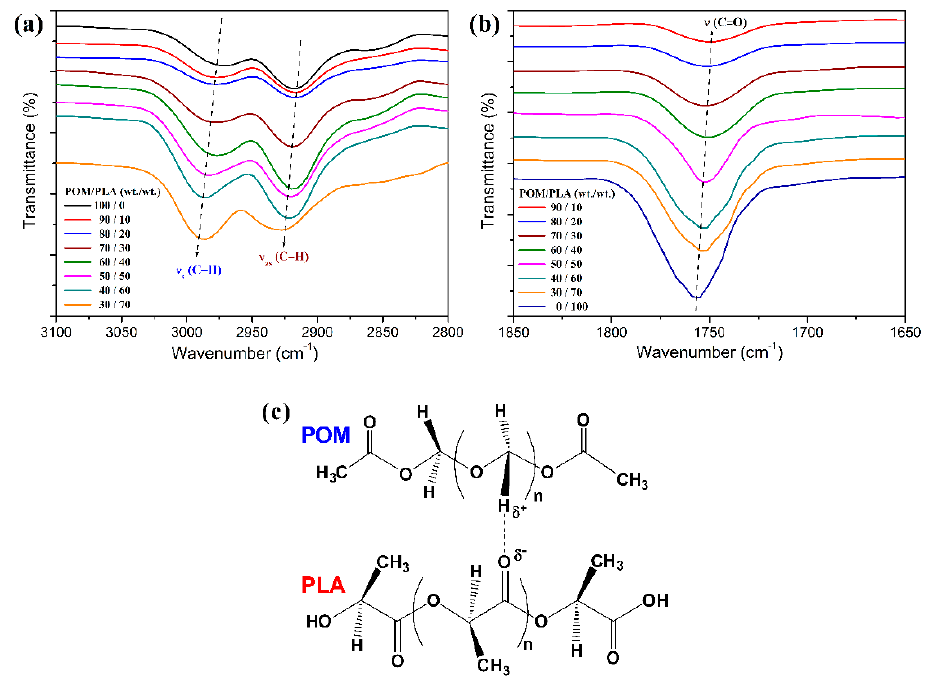
Figure 2. ( a , b ) FTIR spectra of POM / PLA blends at di ff erent mass ratios; ( c ) schematic interaction between the POM and PLA molecules.